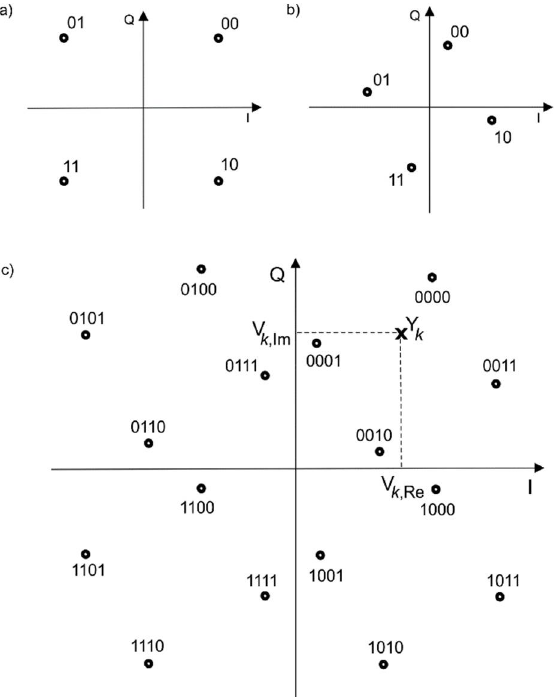
h ( b ), and X X ( a ), QPSK symbol scaled by k k ,1 k ,2